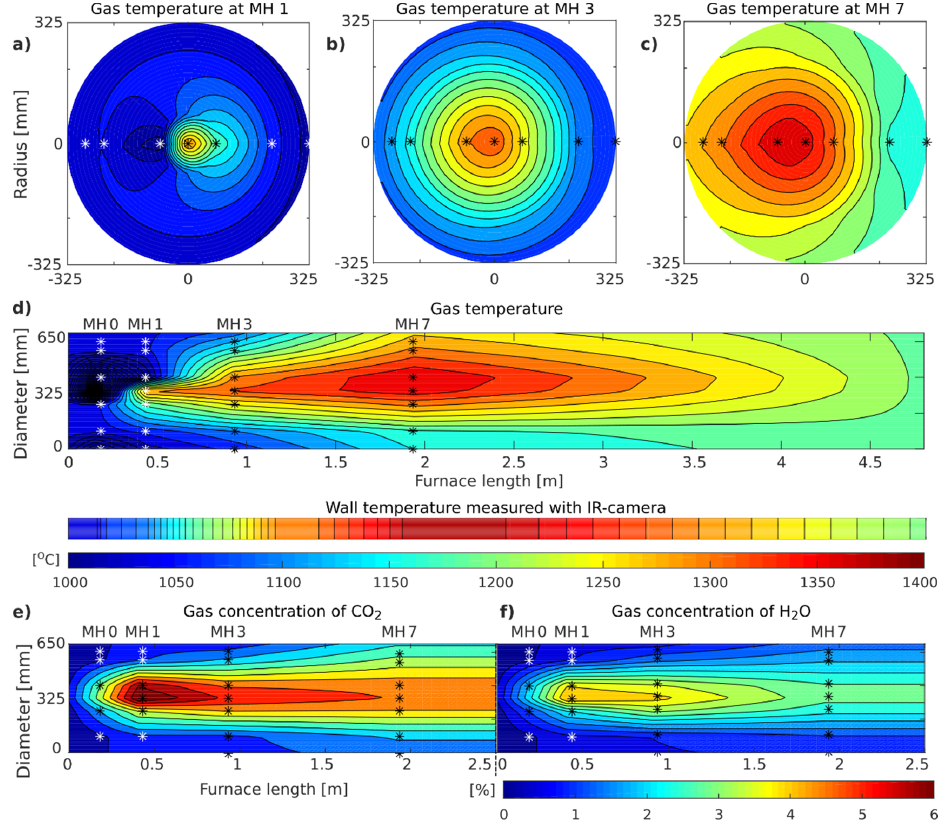
Figure 5. Cross-sectional maps of temperature and gas concentration based on measurements used as input data for the DOM. Temperatures, as seen from the burner position, for ports ( a ) MH 1, ( b ) MH 3, ( c ) MH 7 and ( d ) the whole furnace, as seen from above, including wall temperature measured with an infrared camera. Gas concentrations of ( e ) CO 2 and ( f ) H 2 O. Measurement positions are indicated with asterisk ( ∗ ) symbols.